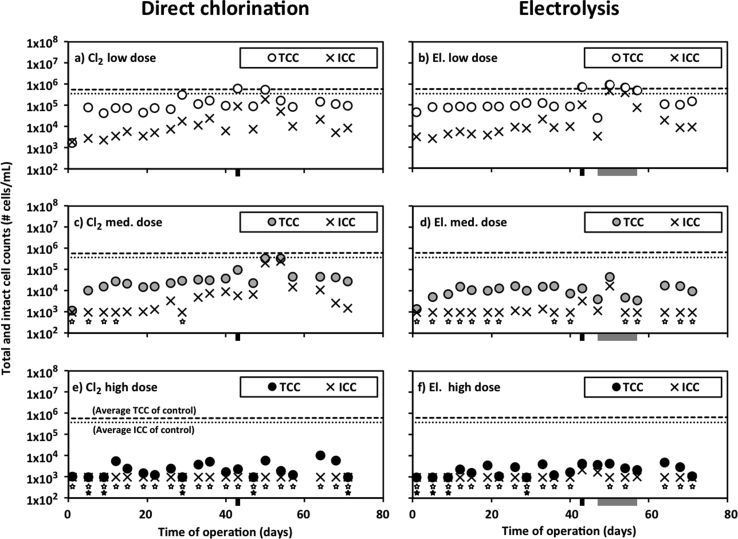
Total cell count (TCC) and intact cell count (ICC) resulting from three different dosages of direct chlorination or electrolysis treatments. Dashed lines indicate the average TCC of the control tank. Dotted lines indicate the average ICC of the control tank. Measurements below quantification are plotted as the quantification limit and indicated using a star placed below the data point. White-filled starts refer to TCC data and black-filled stars refer to ICC data. Black bars beneath the x-axes indicate an interruption in aeration. Grey bars beneath the x-axes indicate an interruption in electrolysis control.